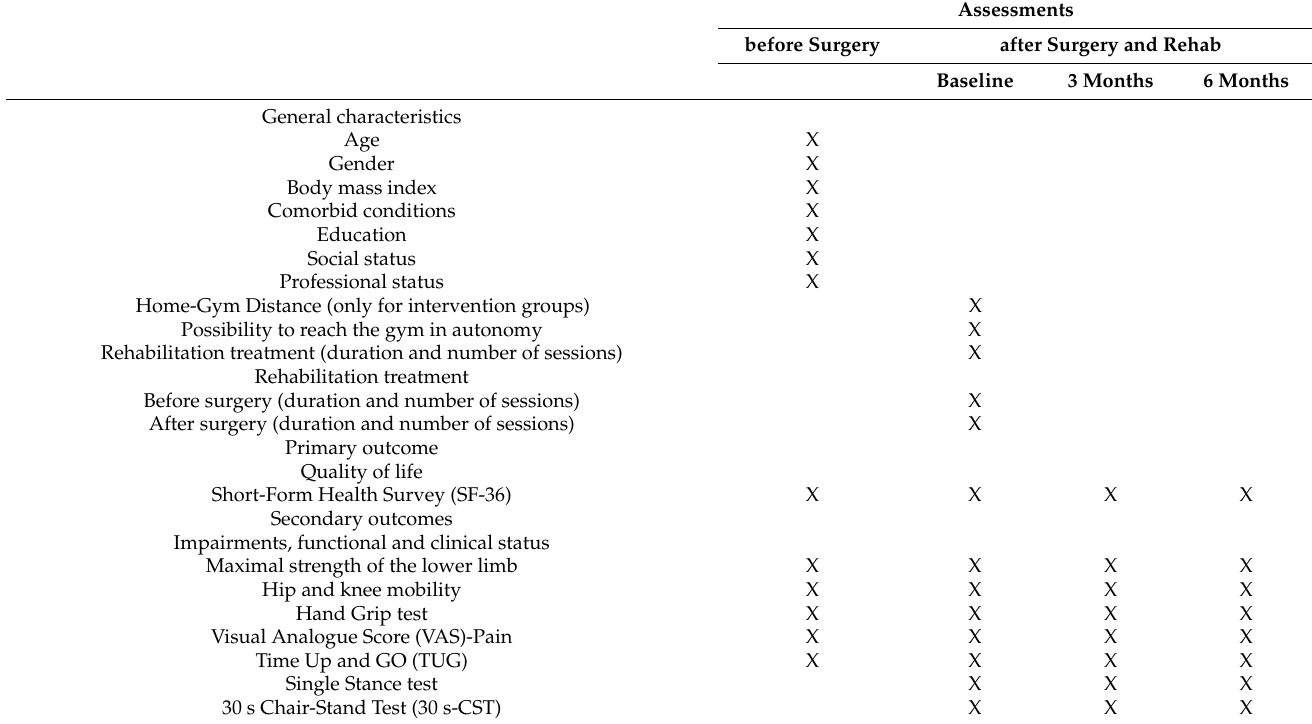
Table 2. Variables collected during the study and time of